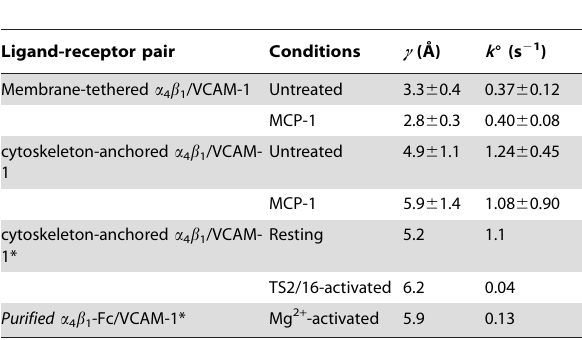
Table 1. Bell model parameters of the membrane-tethered and cytoskeleton-anchored a 4 b 1 /VCAM-1